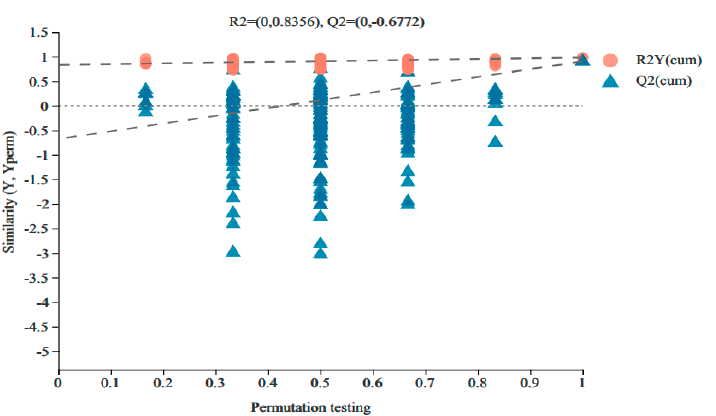
Figure 3. OPLS-DA permutation test diagram of Z-2-GS-2 and GS groups. Note: The abscissa represents the replacement retention of the replacement test (the proportion consistent with the Y variable order of the original model, and the point with the replacement retention of 1 is the R 2 and Q 2 values of the original model), the ordinate represents the values of R 2 (orange dot) and Q 2 (blue triangle) replacement tests, and the two dotted lines represent the regression lines of R 2 and Q 2 ,